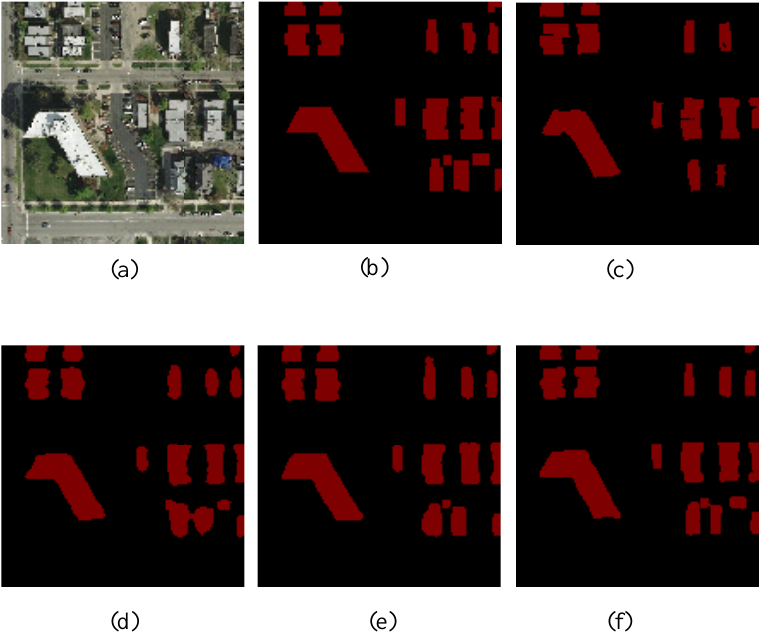
Figure 6. Comparison of reconstruction results using Inria aerial dataset. ( a ) the input image; ( b ) groud truth; ( c ) ResNet50 + ASPP; ( d ) ResNet50 + WASP(AVE); ( e ) LResNet50 + WASP(AVE); ( f ) Our method(LResNet50 + WASP(AVE) + GFG).